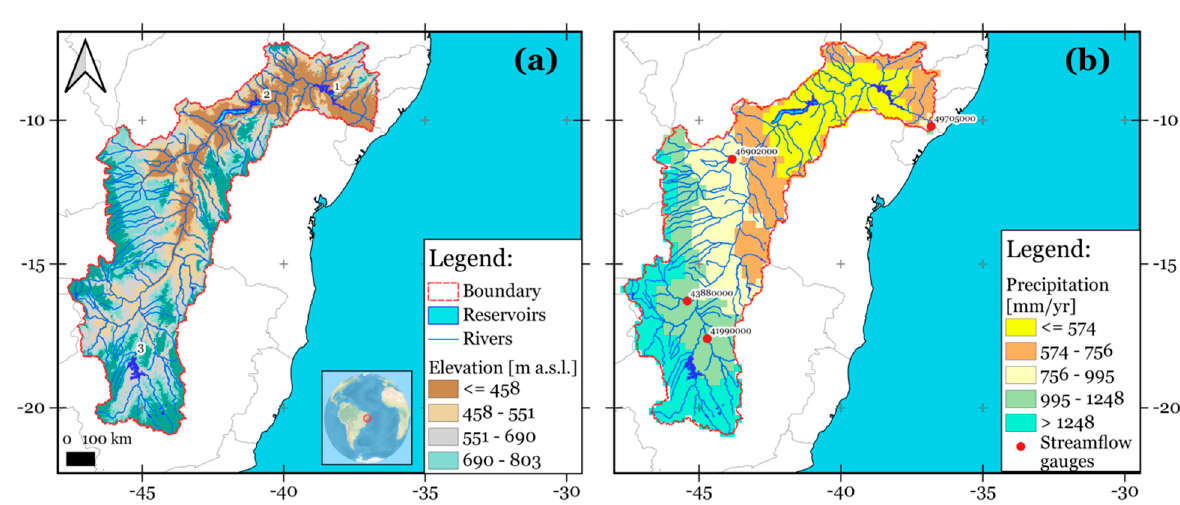
Figure 1. The study area: ( a ) the hydrographic network together with terrain elevation based on 90 m Digital Elevation Model—Shuttle Radar Topographic Mission (DEM-SRTM) images [51]. The spatial distribution of reservoirs Itaparica (1), Sobradinho (2), and Três Marias (3) is shown; ( b ) mean annual rainfall derived from ground-based gridded precipitation dataset developed by Xavier et al. [51] for the reference period 1980–2015. The spatial location of the streamflow gauges Propriá (49705000), Várzea da Palma (41990000), Boqueirão (46902000), and Santo Inácio (43880000) operated by the Brazilian National Water Agency (ANA) is shown.